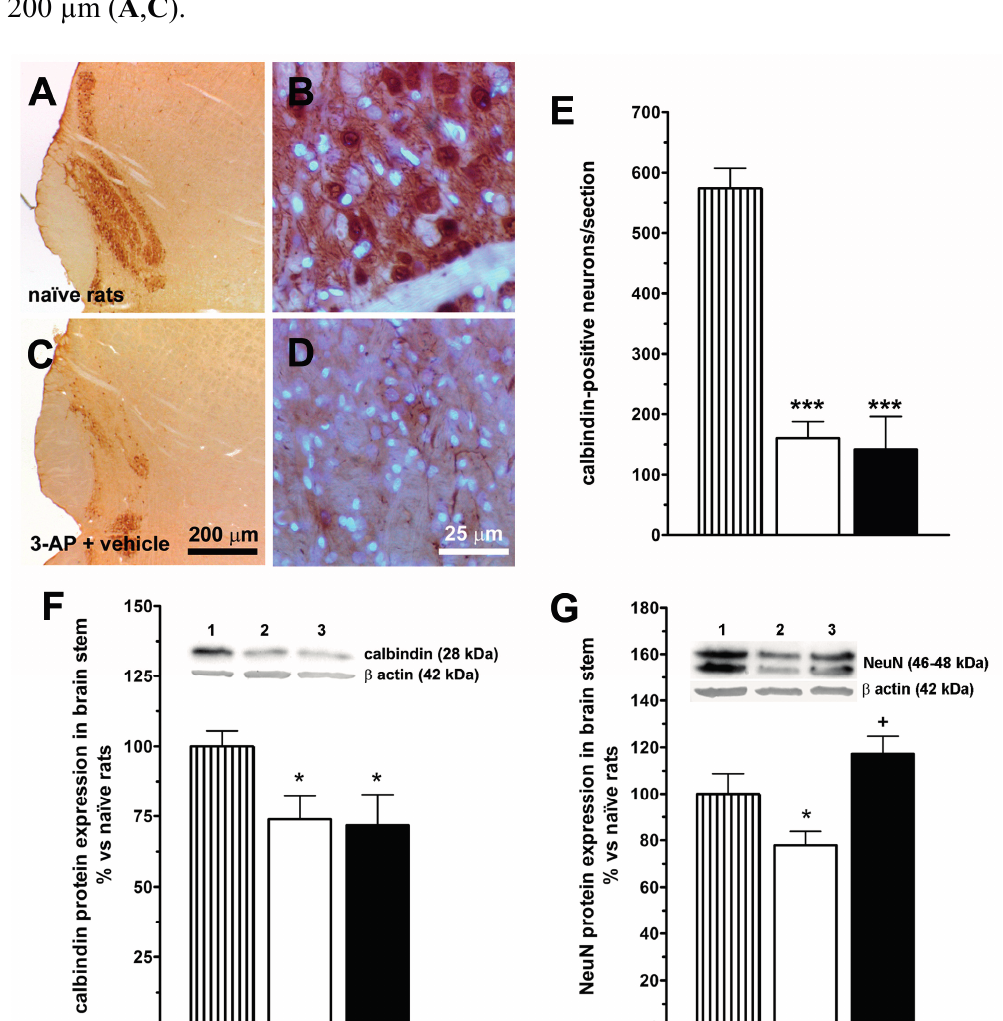
brainstem. Panels A to D show calbindin immunostaining in the inferior olive of naïve ( A , B , brown) and 3-acetylpyridine (3-AP) lesioned rats ( C , D , brown); E shows the number of calbindin-positive neurons/section in the inferior olive of naïve ( E , lined bars) and 3-AP-lesioned rats treated with vehicle ( E , white bars) or LGF ( E , black bars). Note how 3-AP decreases calbindin-positive cells in this structure; F and G show the detection by western blot of calbindin ( F ) and neuronal nuclei ( G , NeuN) in the brainstem. Note how LGF treatment recovers NeuN protein expression in the brainstem of 3-AP-lesioned rats. Lane 1: naïve rats (control); lane 2: 3-AP + vehicle; lane 3: 3-AP + LGF. Results represent the mean ± SEM of 5 to 18 ( E ), or 13 to 18 ( F ), or 4 to 11 ( G ) individual animals. * p ≤ 0.05, *** p ≤ 0.001 vs. naïve rats, + p ≤ 0.05 vs. 3-AP + vehicle rats. Scale bars: 25 µm ( B , D ) and 200 µm ( A , C